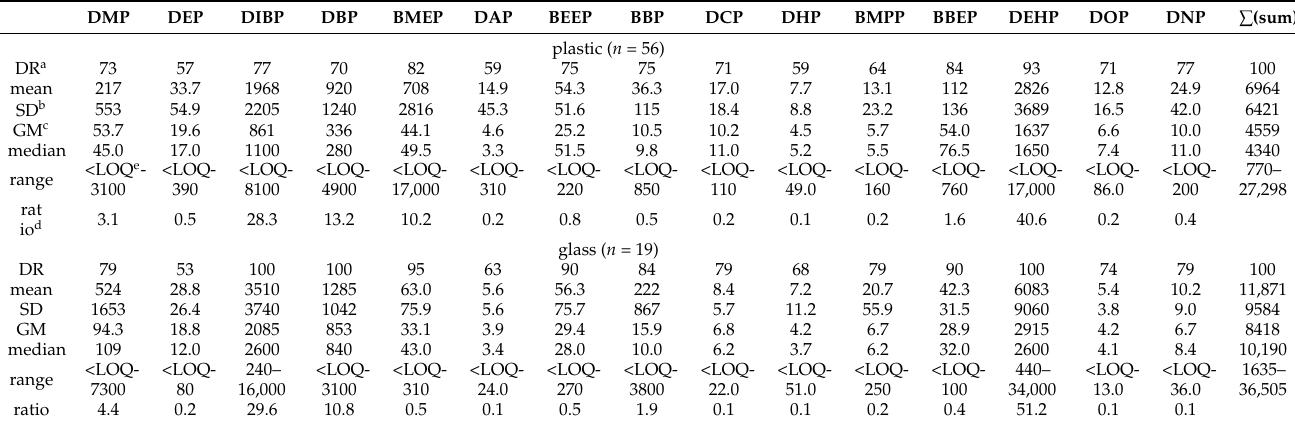
Table 4. Concentrations (ng/L) of phthalates in bottled drinks sorted by the packaging